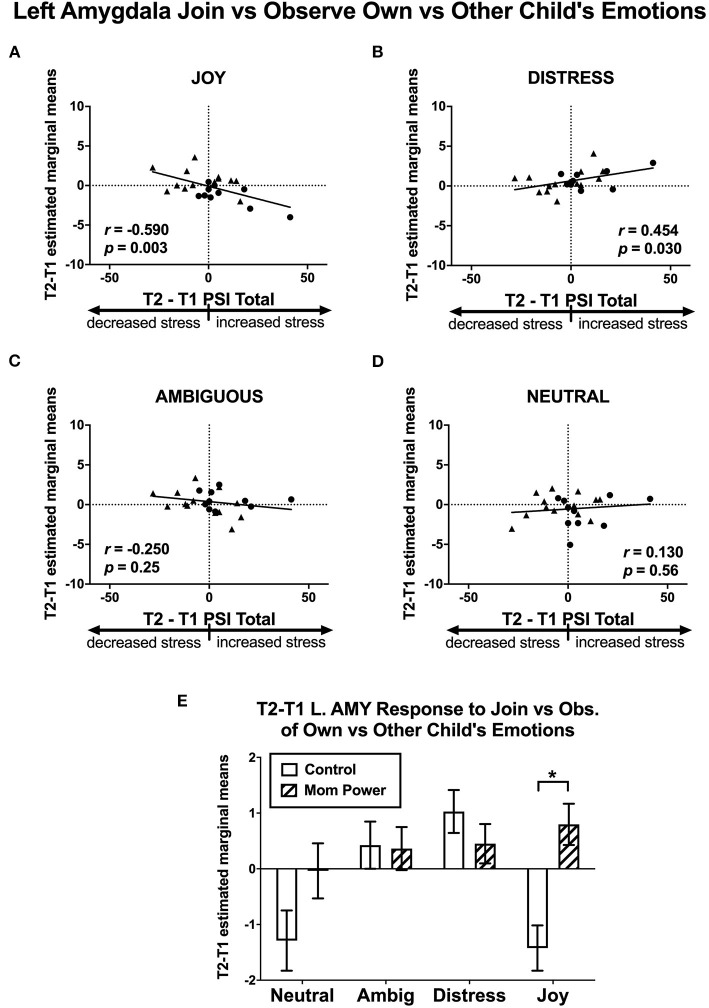
Scatter plots of Study 2 T2-T1 changes in PSI (x-axis) and T2-T1 differential responses in the left amygdala (y-axis) in the contrasts of MMR(joy) (A), MMR(dis) (B), MMR(amb) (C), and MMR(neu) (D). The T2-T1 left amygdala MMR(all) responses were increased in MP but decreased in Control group (E). *p < 0.05.